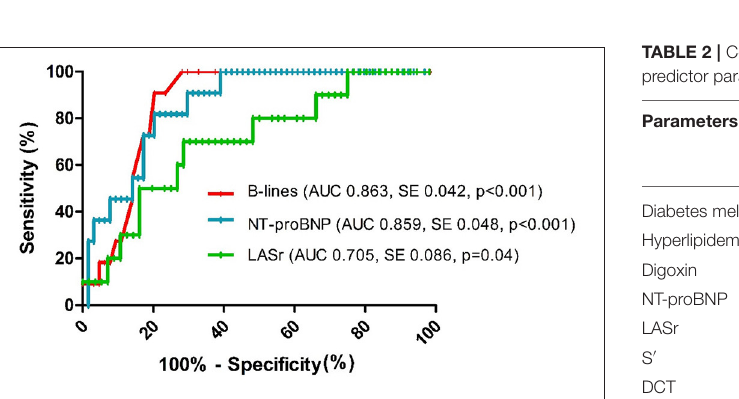
FIGURE 3 | ROC curves for the prediction of endpoint events (AUC, Area under the curve; SE, standard error).